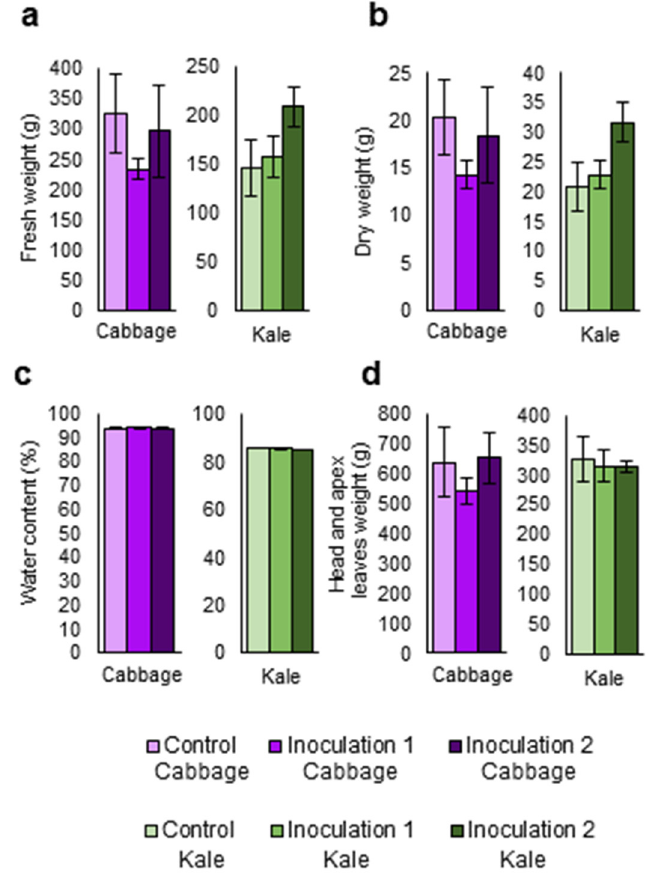
Figure 5. Parameters related to the biomass and physiology of two Brassica oleracea crops inoculated with Xanthomonas campestris pv. campestris in a field trial. ( a ) Weight of fresh leaves. ( b ) Weight of dry leaves. ( c ) Water percentage of leaves. ( d ) Cabbage head weight and wight of kale apex leaves. Data represent the averages of 3 repetitions for each crop: B. oleracea var. capitata (cabbage) and B. oleracea var. acephala (kale). Bars represent the standard error.